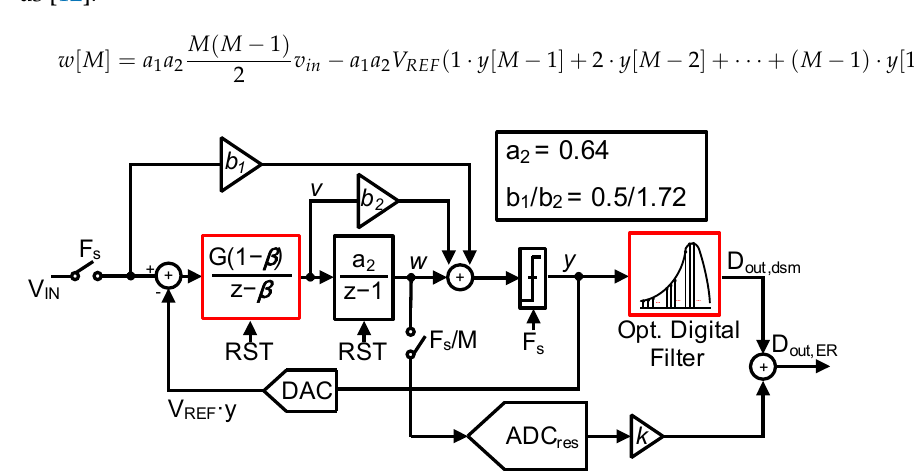
Figure 3. A block diagram of the 2nd-order DT IDSM architecture using a passive integrator and optimal digital decimation filter.